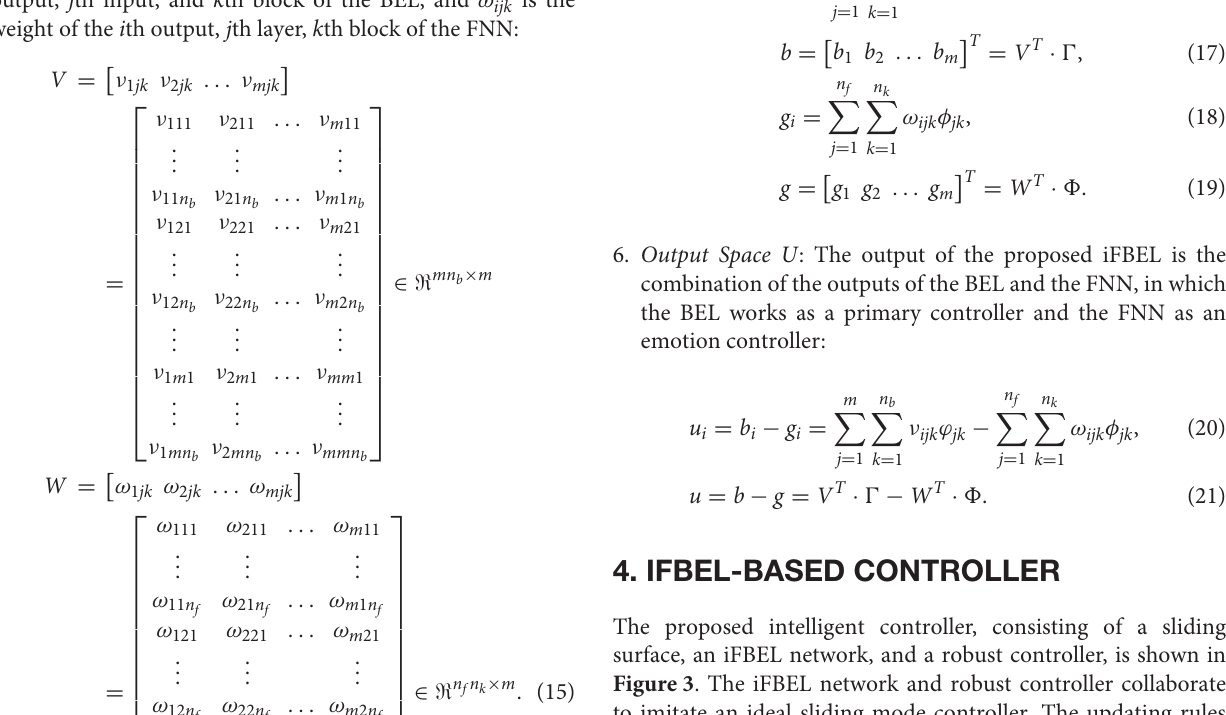
4. Weight Memory Spaces V and W : ν ijk is the weight of the i th output, j th input, and k th block of the BEL; and ω ijk is the weight of the i th output, j th layer, k th block of the FNN: V =